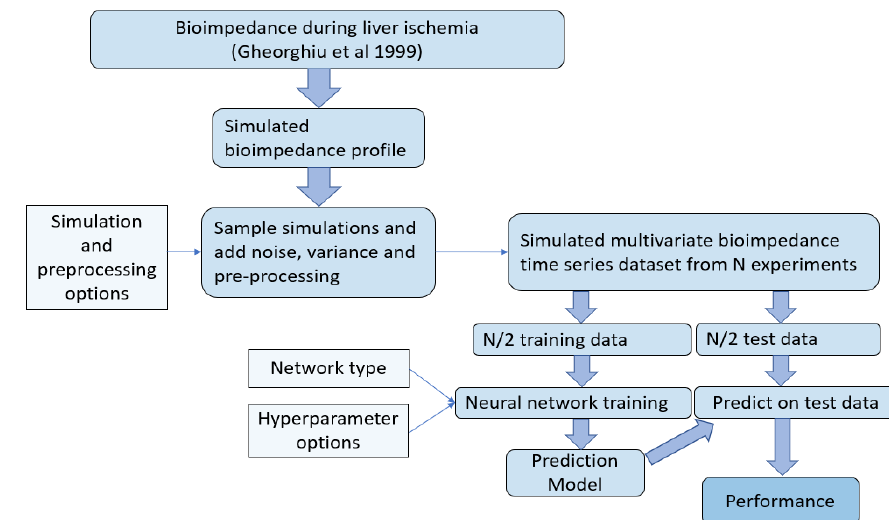
Figure 2. Overview of the methodology used for investigating the performance of different neural networks for predicting duration of ischemia based on bioimpedance using simulated